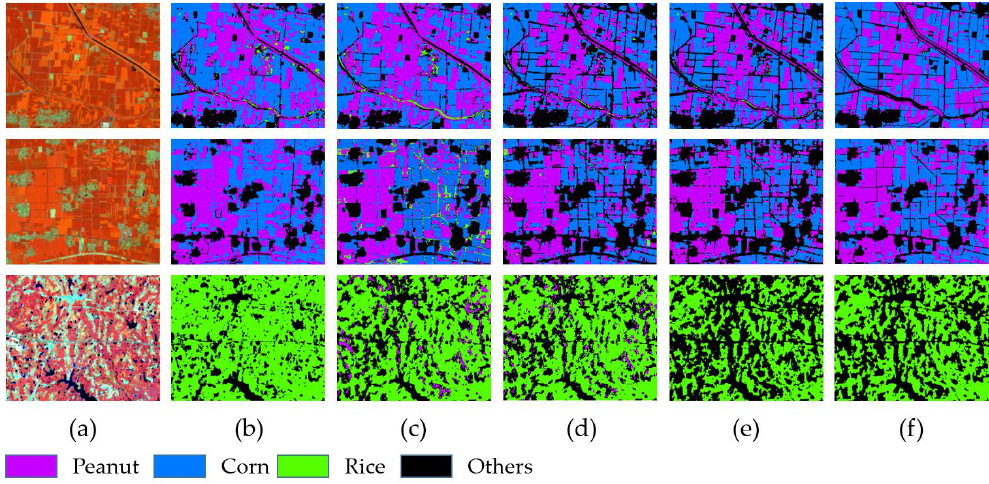
Figure 11. Some examples of crop classification ablation experiments. From left to right: ( a ) Band 8, Band 11, Band 4 false color synthesis of Sentinel-2 image; ( b ) baseline; ( c ) Experiment 1; ( d ) Experi- ment 2; ( e ) Experiment 3; ( f ) Experiment 4.